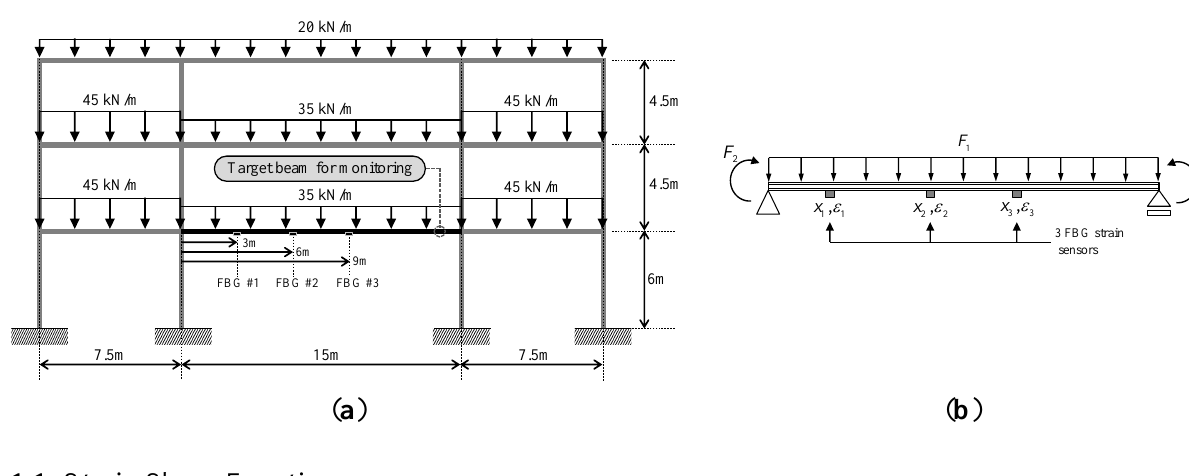
Figure 3. Numerical example for simulation. ( a ) Target two-dimensional steel beam frame. ( b ) Equivalent structural model of the